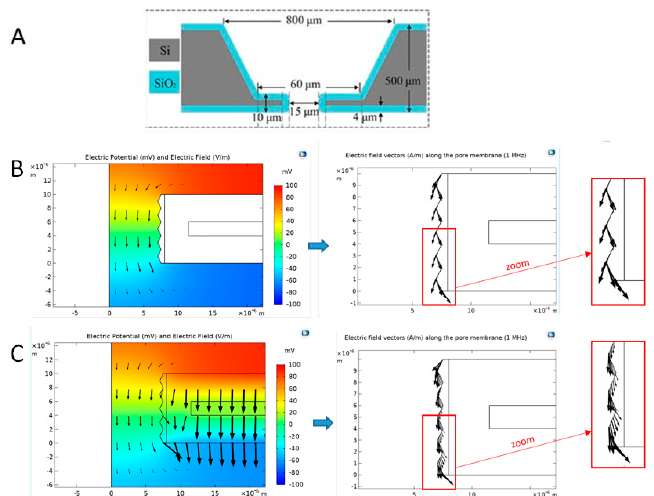
Figure 2. Distribution of the electric field in a micrometric pore made in a silica-covered silicon membrane. ( A ) Schematic side-view of a 15 µm-wide micropore. ( B ) Numerical simulation of a perfectly insulated pore membrane immersed in a 100 mM KCl solution in contact with two Ag / AgCl electrodes at applied potentials + 100 mV (top electrode) and − 100 mV (bottom electrode). ( Left) The complete potential drop is confined inside the pore at 1 MHz (colors). Vectors (black) represent the resulting electric field distribution. ( Right ) Electric field vectors along the pore membrane boundary: As expected, the electric field is tangential to the membrane surface. ( C ) Numerical simulation taking into account the dielectric properties of the pore membrane (Si covered by a 4 µm-thick SiO 2 layer). ( Left ) The SiO 2 layer of the pore membrane is highly polarized as it experiences the complete drop of the applied potential ( + 100 to − 100 mV). ( Right ) Electric field vectors along the pore membrane boundary: The electric field displays a non-zero component normal to the membrane surface.